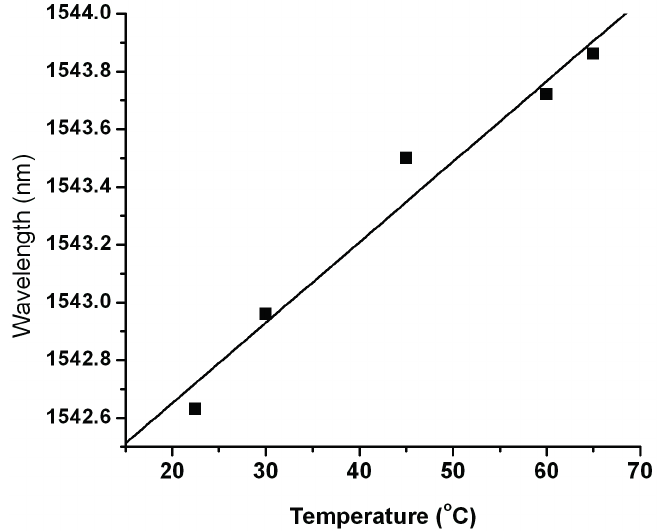
Figure 3. Calibration curve of the fiber Bragg gratings (FBG) sensor.